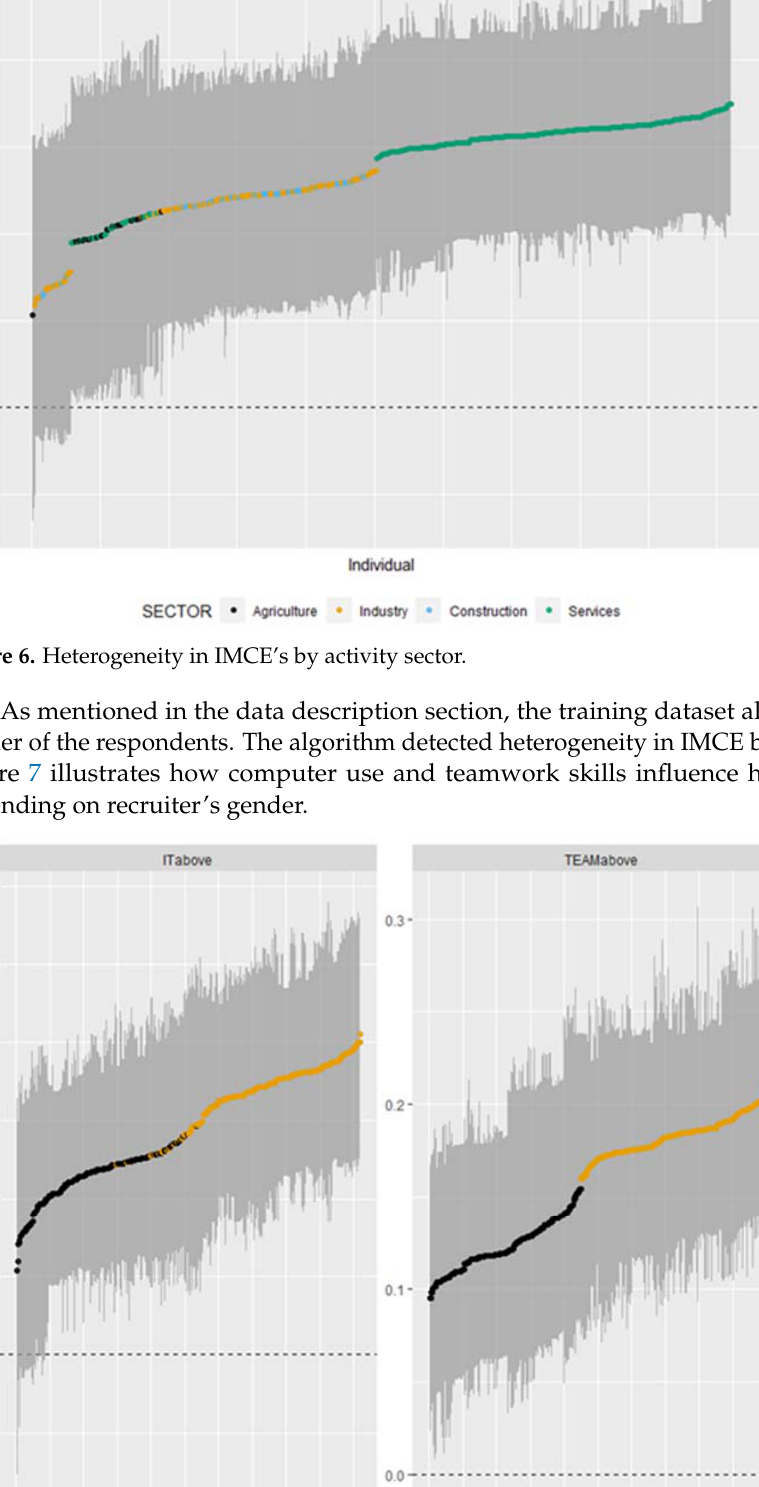
Figure 5. Heterogeneity in IMCE’s by company ownership covariate.